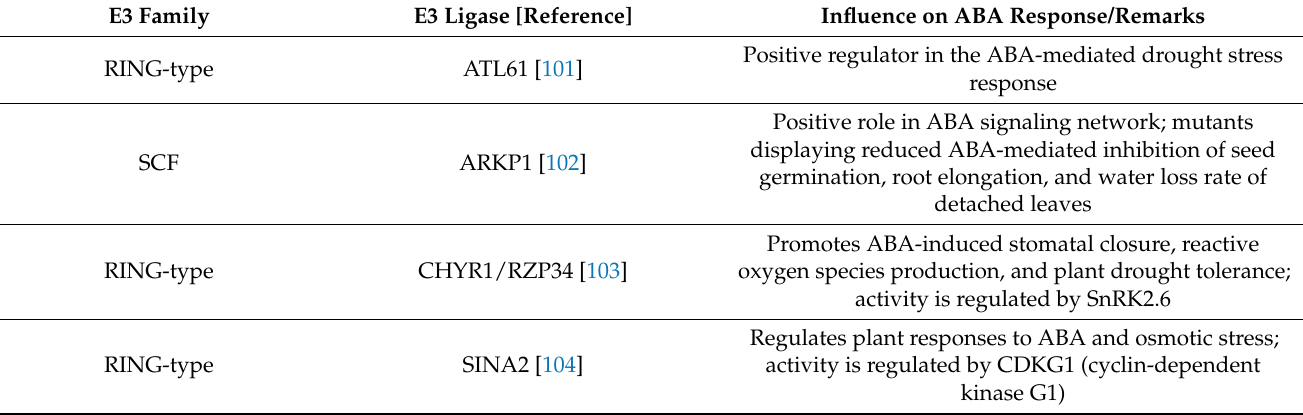
Table 2. E3 ligases with unidentified targets that are known to regulate ABA responses. The original references are provided next to the E3 ligase; however, this table is a compilation of the tables from several earlier reviews [6,7,12,99,100], as well as new data that were not previously